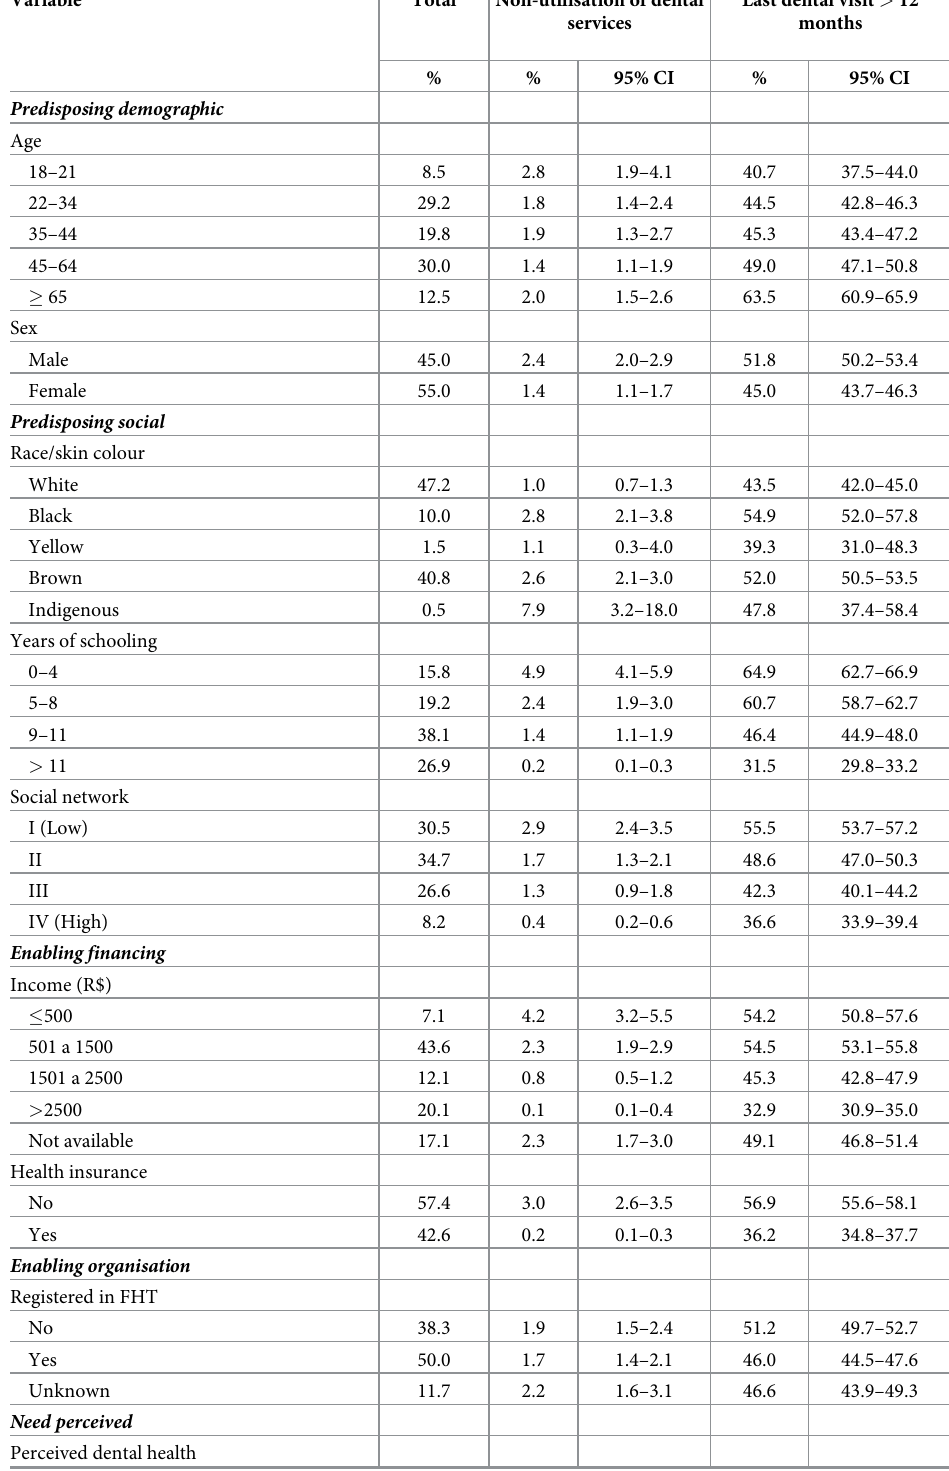
Table 1. Individual predisposing, enabling and need characteristics according to non-utilisation of dental services and last dental visit over 12 months ago.